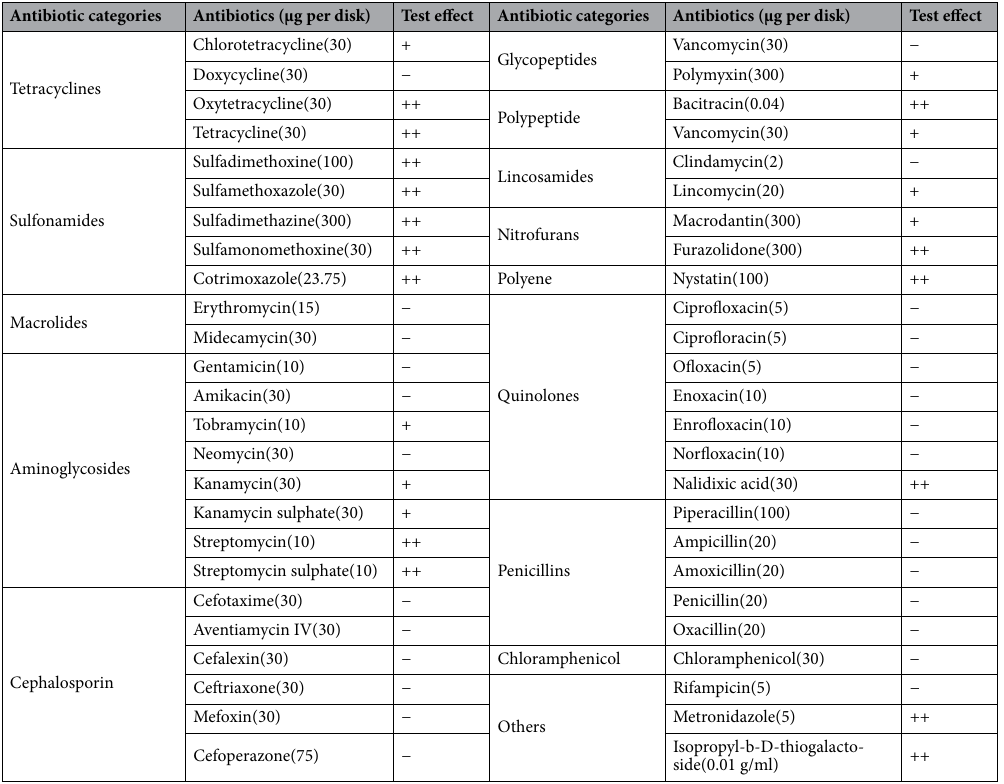
Table 1. Inhibitory effect of tested drugs on growth of strain OTC-16. Note: -: Strain OTC-16 is highly sensitive to the drugs (diameter of bacteriostatic circle ≥ 1.3 cm); ++: strain OTC-16 is high resistant to the drugs (No bacteriostatic circles were observed); +: strain OTC-16 is medium resistant to the drugs (diameter of bacteriostatic circle < 1.3